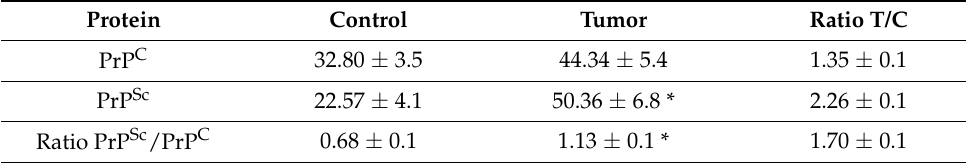
Table 1. PrP C compared with PrP Sc in control and PDAC